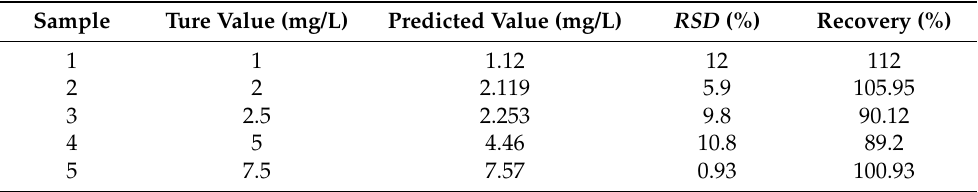
Table 5. The results between the real values and predicted values of TBZ in red soil extracts.